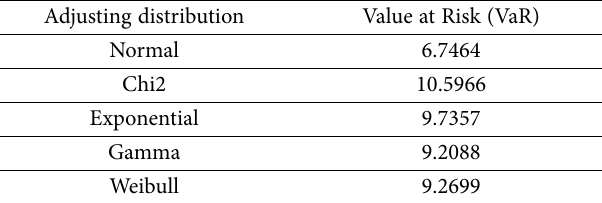
Table 3. Estimation of 99.5% quantile with the parametric estimator Adjusting distribution